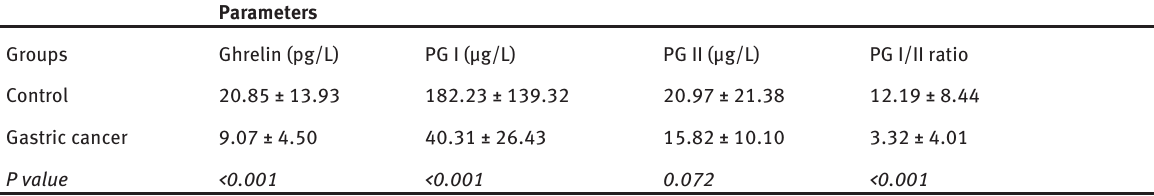
Table 1: Plasma levels of ghrelin and serum levels of pepsinogen I, pepsinogen II, and pepsinogen I/II ratio in both gastric cancer patients and control group patients.